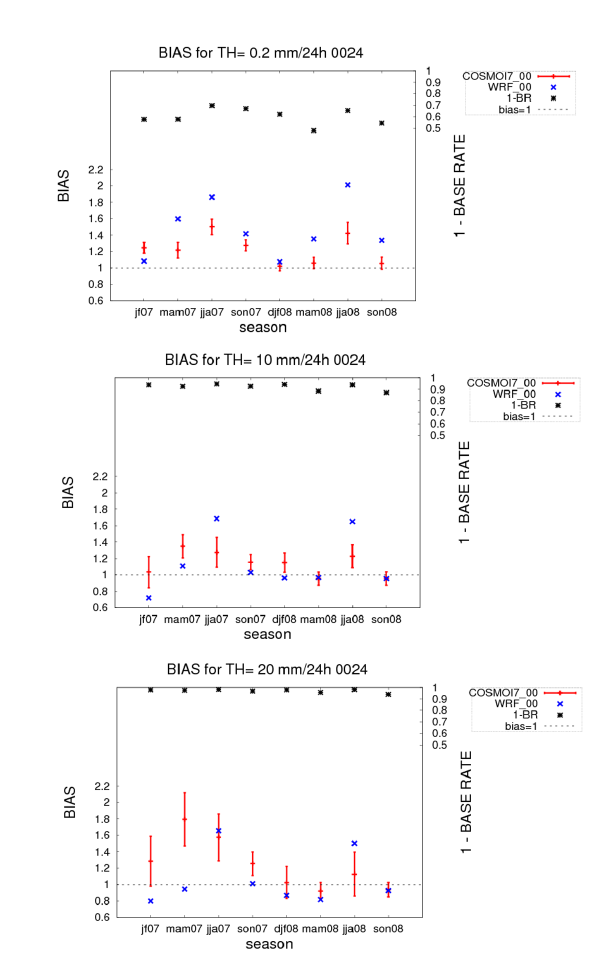
Fig. 6. Seasonal trend: BIAS vs. increasing thresholds (0.2mm24h − 1 , 10mm24h − 1 , 20mm24h − 1 ) for the first day of forecast. The dashed red lines and the blue daggers represent COSMO-I7 and WRF, respectively. The Base Rate (stars) is plotted for each threshold.